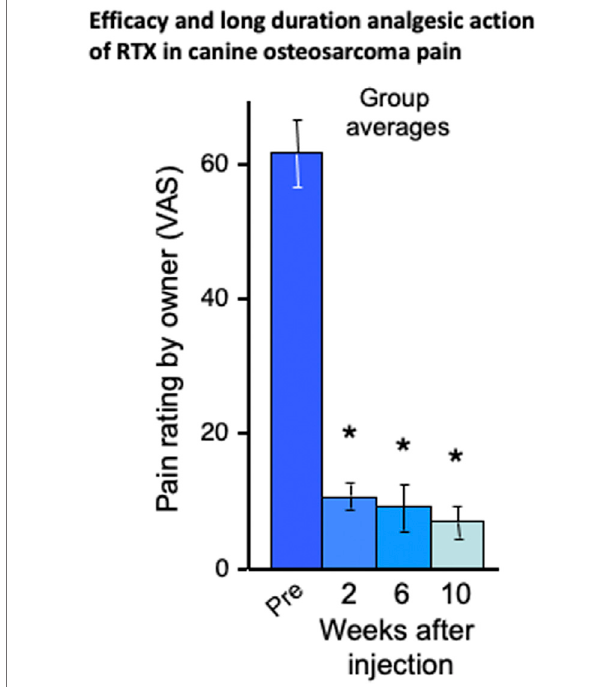
FIGURE 2 | Ef fi cacy and long duration analgesic action of RTX in companion canine model. RTX analgesia was tested in naturally occurring neoplasms and/or osteoarthritis in the dog after a single intrathecal dose of a single intrathecal dose of RTX (1 μ g/kg) administered under general anesthesia via cisternal puncture. Reports by the owners using Visual Analog Scaleratingdemonstratedasustainedreduction inpainintheeight dogs.The bars represent the average rating ± SEM (*ANOVA with Scheffe ’ s post hoc test; p < 0.05). The animals initially presented with limb guarding as they walked, but this improved over time and daily activity increased, as was evident from video recordings. In fact, the entire demeanor of the dogs appeared improved following intrathecal RTX treatment. The ef fi cacy of RTX action was further demonstrated by discontinuation or reduction in the use of supplementary analgesics (opioids and NSAIDs in all eight dogs). As the time pointsonthe X axisshow,theRTX-inducedanalgesiadidnotdiminishdespite neoplastic advancement. These data formed a bridge between the initial rodent data Karai et al. (2004) and the human clinical trials in cancer pain as depicted schematically in Figure 1 and with preliminary human result in Figure 3